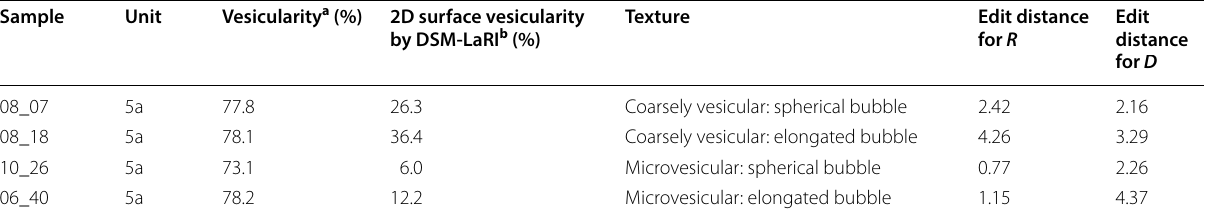
a Measured by the Archimedes method (Houghton and Wilson 1989) b Bubbles are recognized by DSM-LaRI